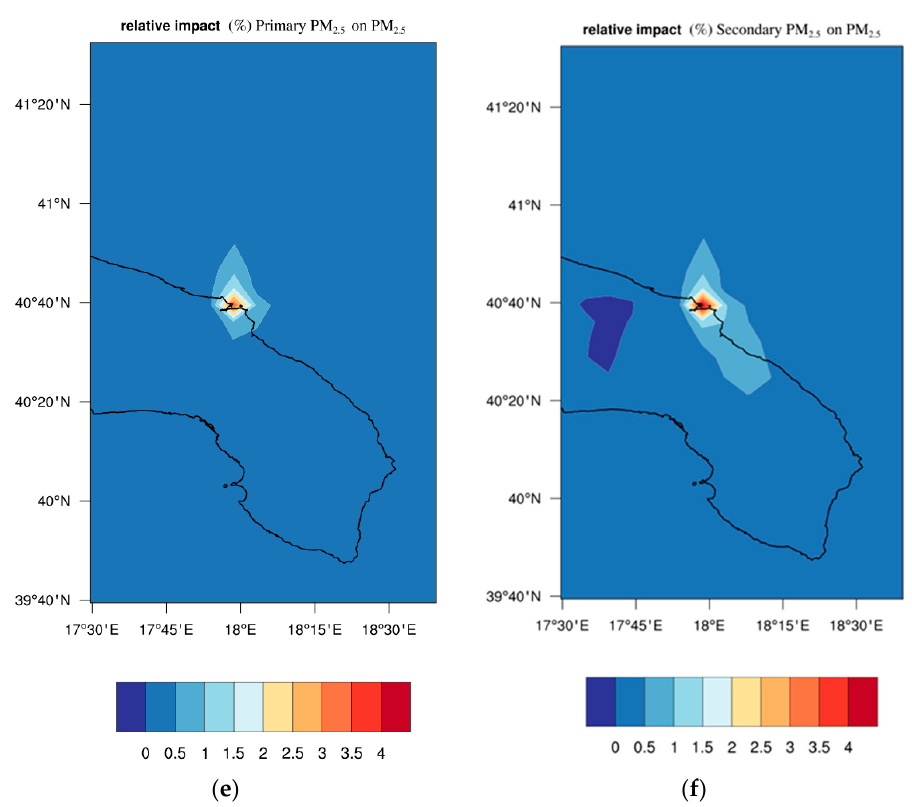
Figure 6. Average relative impact of ship emissions (%) on ( a ) NO X , ( b ) O 3 , ( c ) total PM 2.5 , ( d ) total PM 10 , ( e ) primary PM 2.5 , and ( f ) secondary PM 2.5 obtained from BOLCHEM for the period June–October